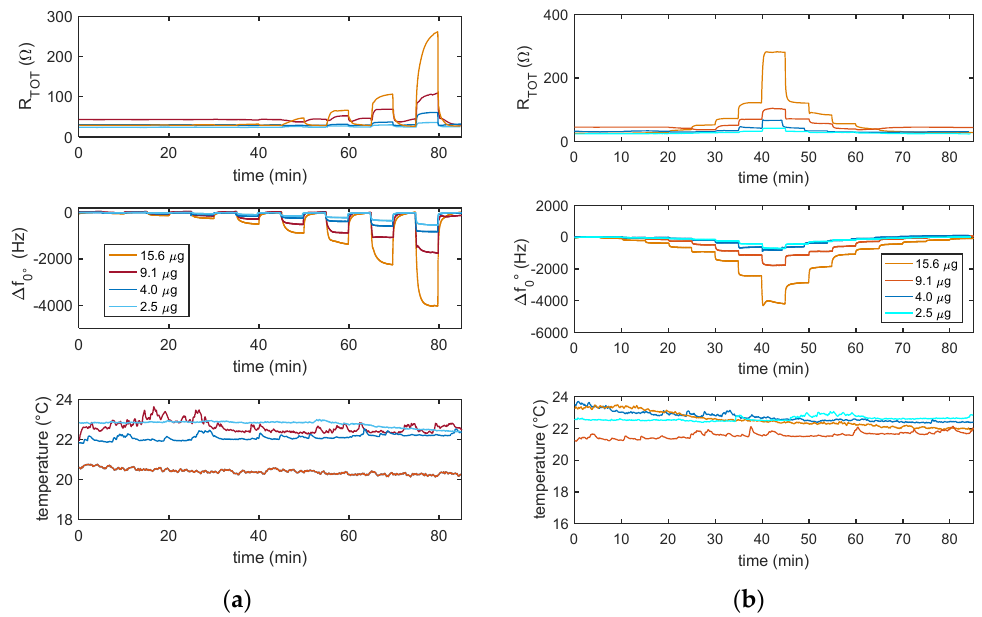
Figure 8. Dynamic response of the realized sensors in time by varying RH with pulses of 10% ( a ) and steps of 10% ( b , staircase) covering the RH range 0–80%.